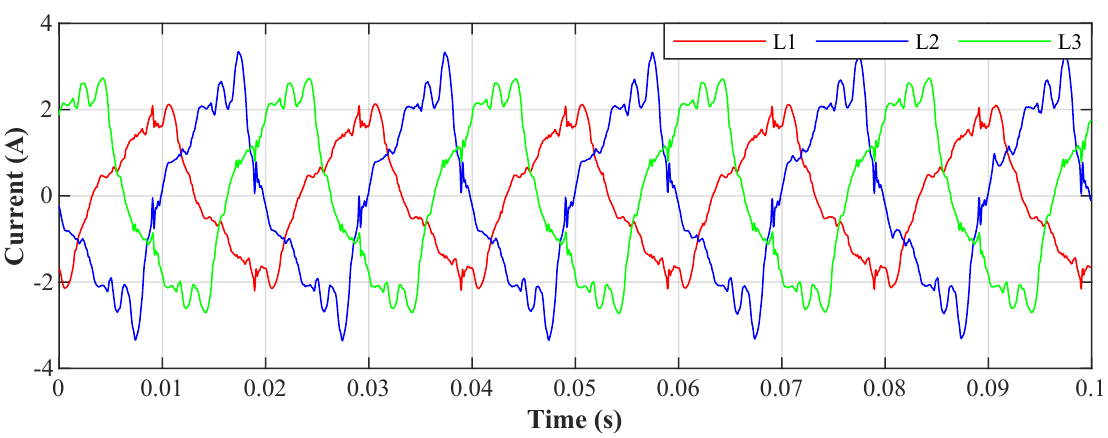
Figure 30. Current waveforms of individual phases before filtration.